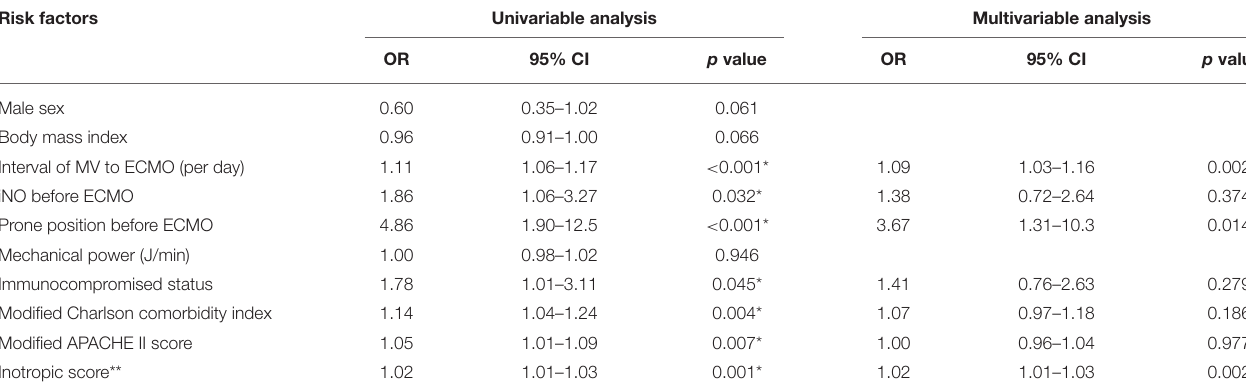
TABLE 2 | Risk factors of failure to wean from ECMO in the patients who received ECMO for ARDS by logistic regression. Risk factors Univariable analysis